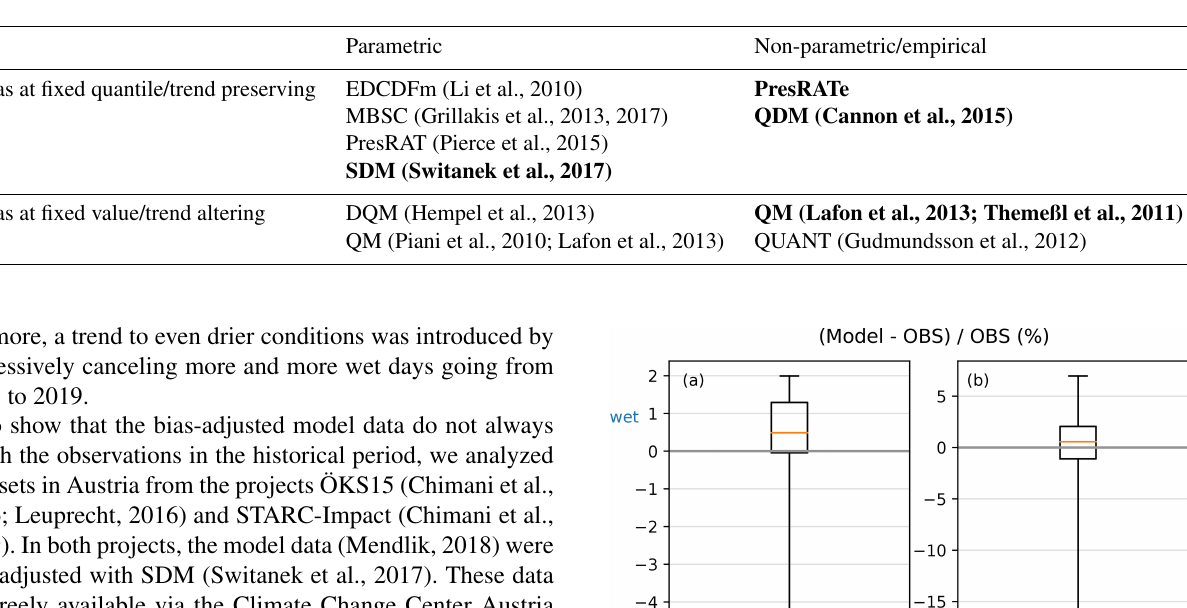
Table 1. Grouping of some quantile-based bias-adjustment methods in two categories. Note that this list is not complete. The methods in bold are used in this work.